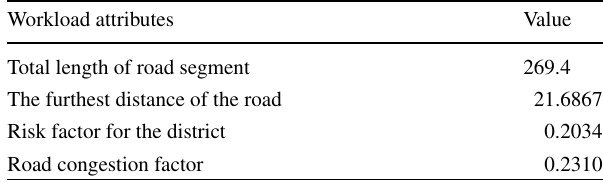
the other algorithms. The results indicate that the proposed algorithm outperforms the others for different numbers of districts.